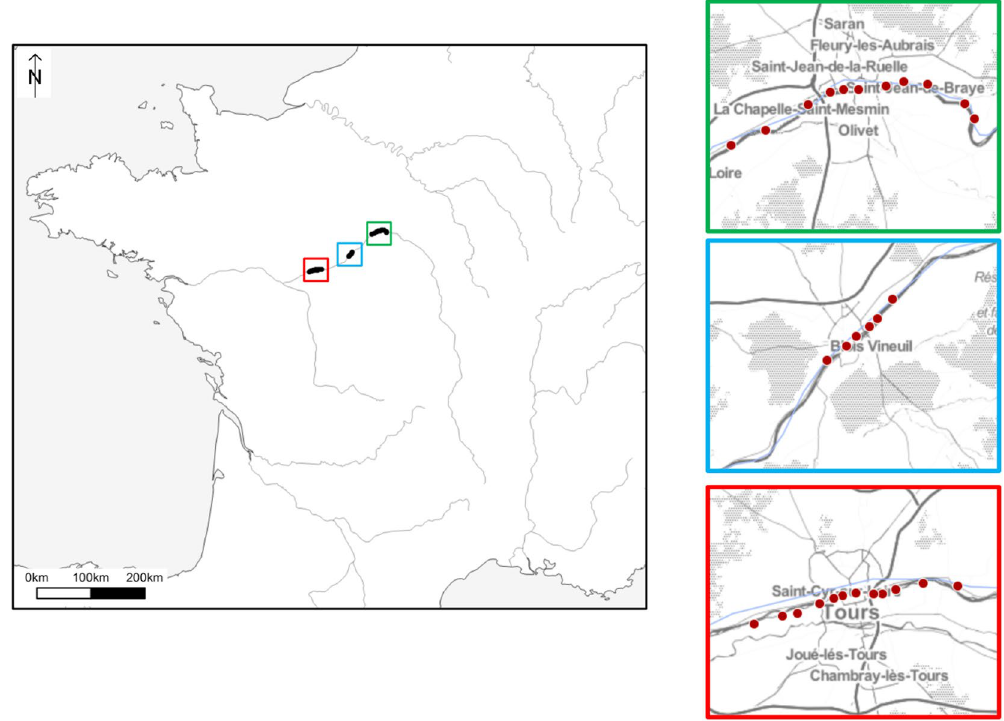
Figure 1. Map locations for all sampling from the three main regions in the Loire Valley. The software QGIS v.3.8 was used to represent sampling sites